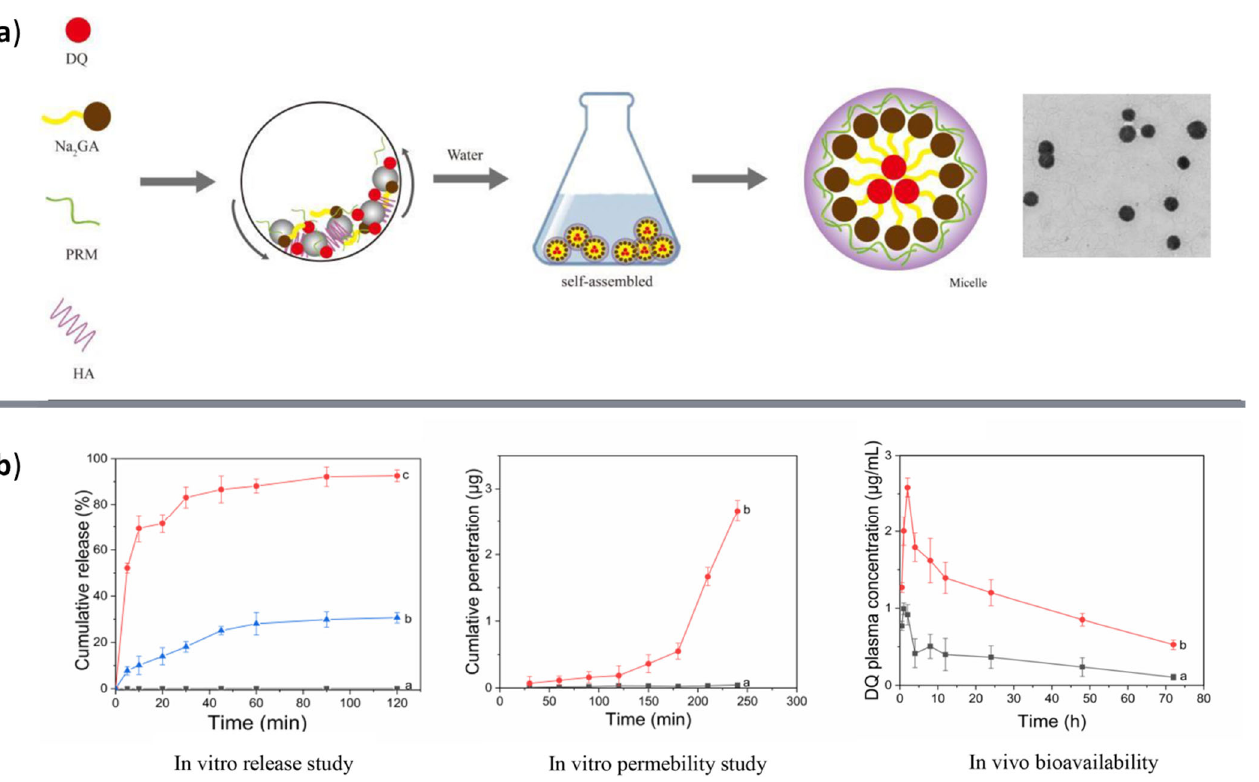
Figure 9. ( a ) Visual representation for the fabrication of decoquinate delivery system and ( b ) systematic testing. Reprinted with permission from [142], © Elsevier, 2022.